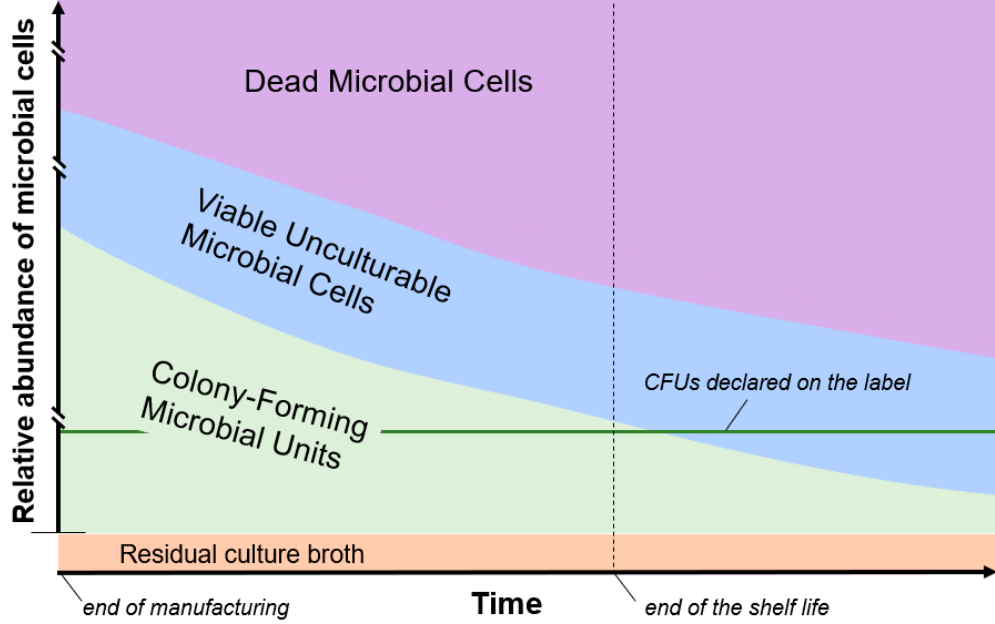
Figure 1. Exemplifying representation of the microbial viability states of a hypothetical probiotic product over time. The relative abundance of viable cells (green) progressively decreases over time, whereas that of dead cells (violet) progressively increases. Conversely, viable unculturable microbial cells (light blue) can potentially both increase and decrease over time. Culture broth residues from the manufacturing process are also present in the final formulation (orange). The real kinetics of the change in relative abundances is not represented.